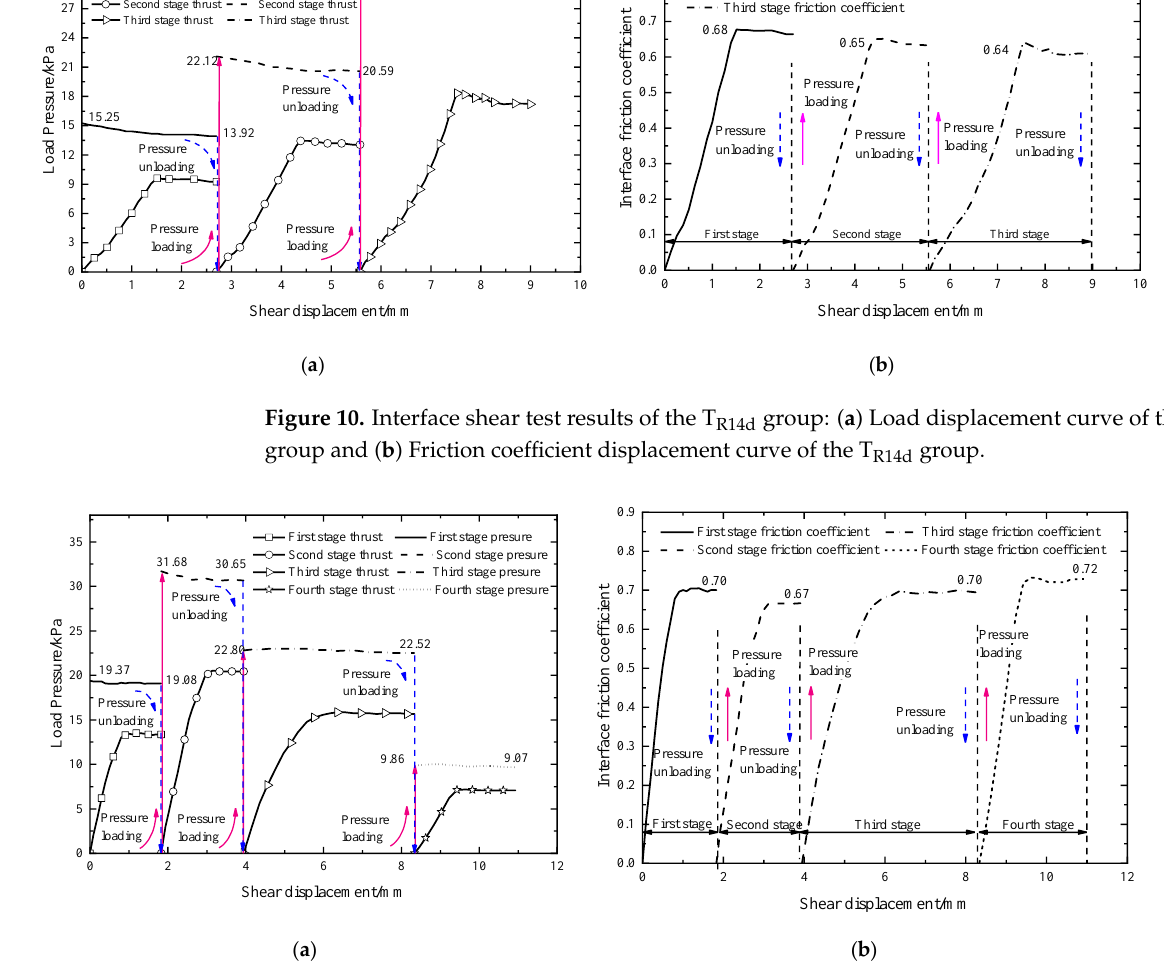
Figure 11. Interface shear test results of T R28d group: ( a ) Load displacement curve of the T R28d group and ( b ) Friction coefficient displacement curve of the T R28d